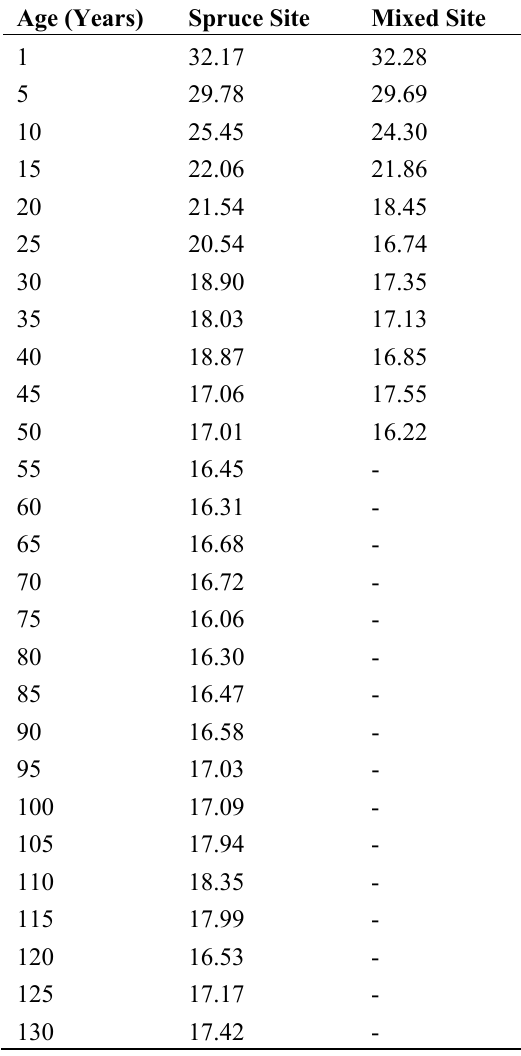
Table 2. Mean microfibril angle (degrees) at given ages for white spruce trees originating from the spruce site (PSP 379) and the mixed site (PSP 434). n = 100 for the spruce site, while n = 50 for the mixed